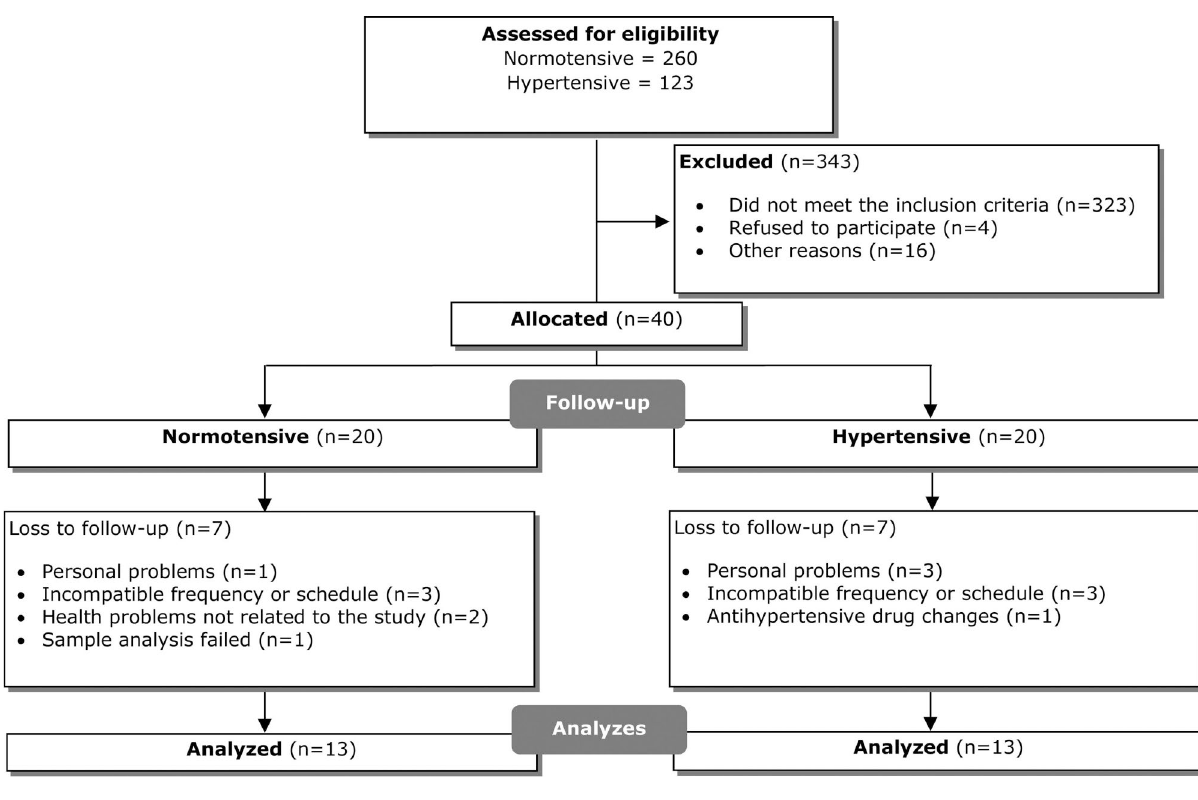
Figure 2 - Flowchart.